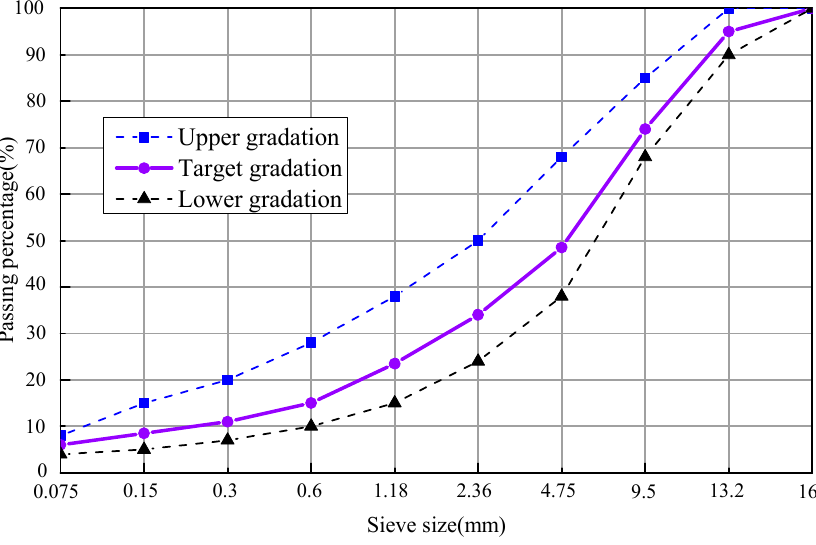
Figure 1. The design grading curve.